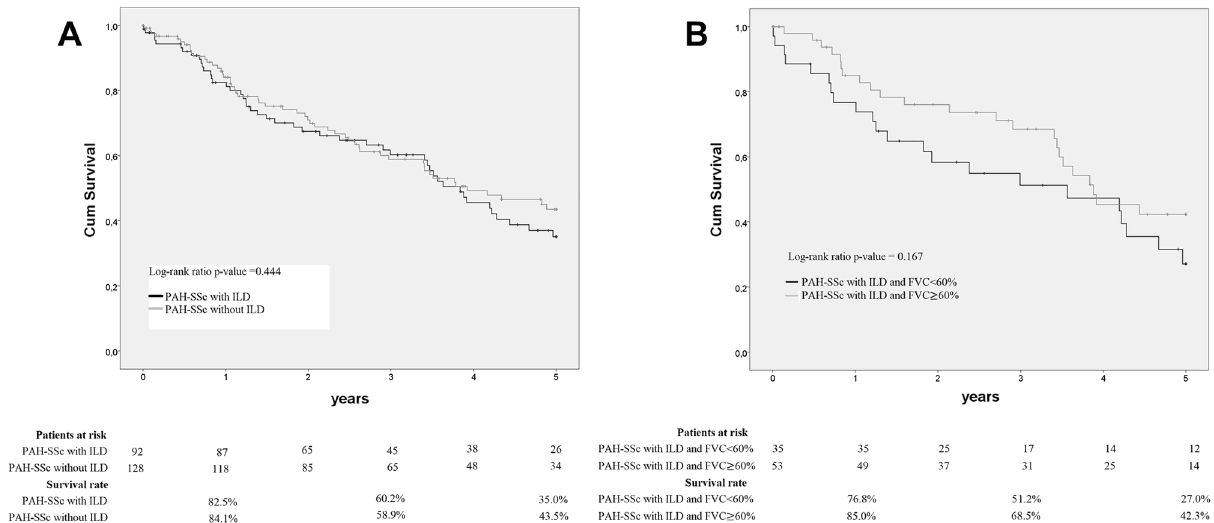
Figure 2. Kaplan–Meier analysis of transplant-free survival in patients with PAH-SSc according to ( A ) presence of ILD and ( B ) severity of the restrictive lung